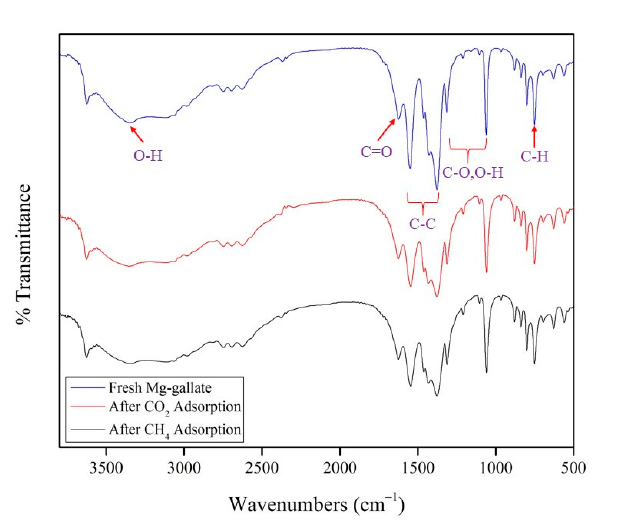
Figure 3. FTIR spectra of Mg-gallate.